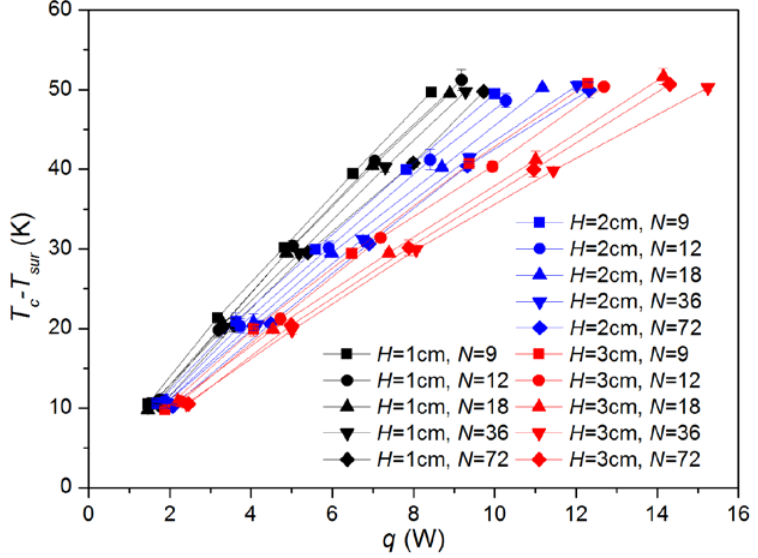
Figure 5. Temperature differences for various heat inputs. Table 3. Experimental results.